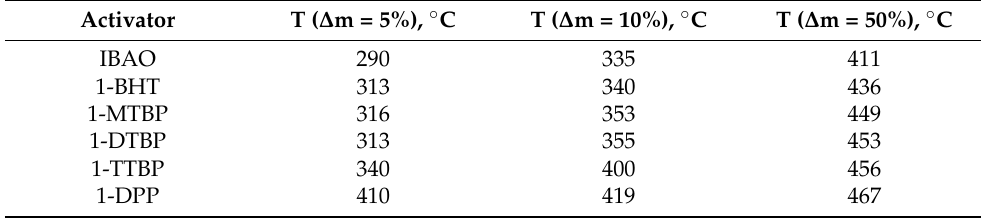
Table 4. Temperature values of mass loss in air in the range from 5 to 50% for E/P copolymers obtained with different monoaryloxide